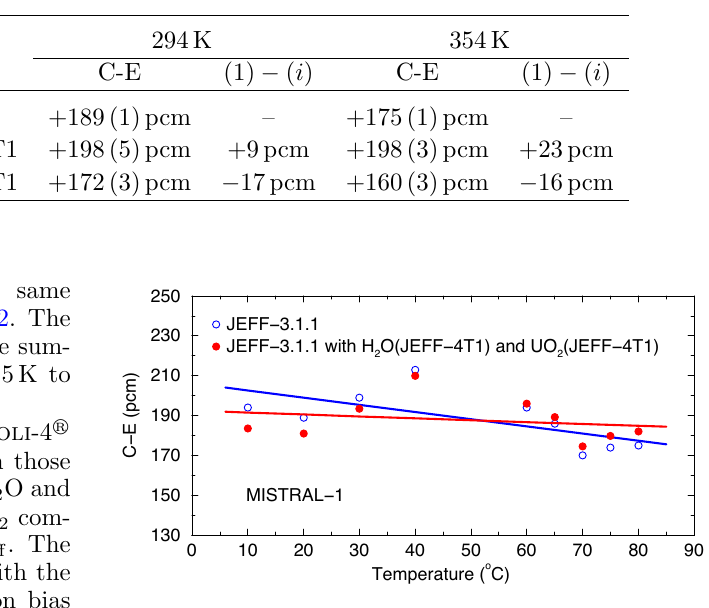
Fig. 12. Differences in reactivity for the MISTRAL-1 core obtained with T ripoli -4 (cid:114) . The solid blue line is the best-fit curve obtained with the JEFF-3.1.1 library alone (see Fig. 5). The solid red line is the best-fit curve obtained when the ther- mal scattering laws of H 2 O and UO 2 are replaced by those of JEFF-4T1. The slope of each line gives the calculation bias on the isothermal reactivity temperature coefficient α iso . For clarity, the uncertainties are shortly discussed in Section 3 and not reported in the